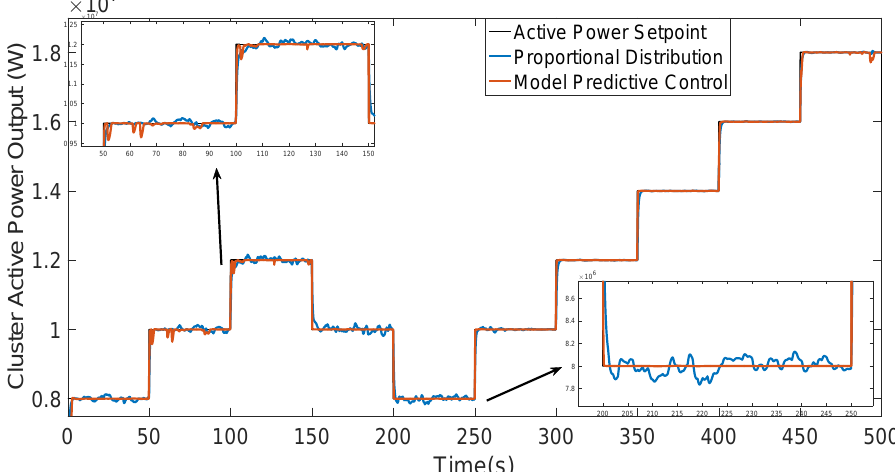
Figure 3. Active power output of wind-turbine cluster under step power demand.